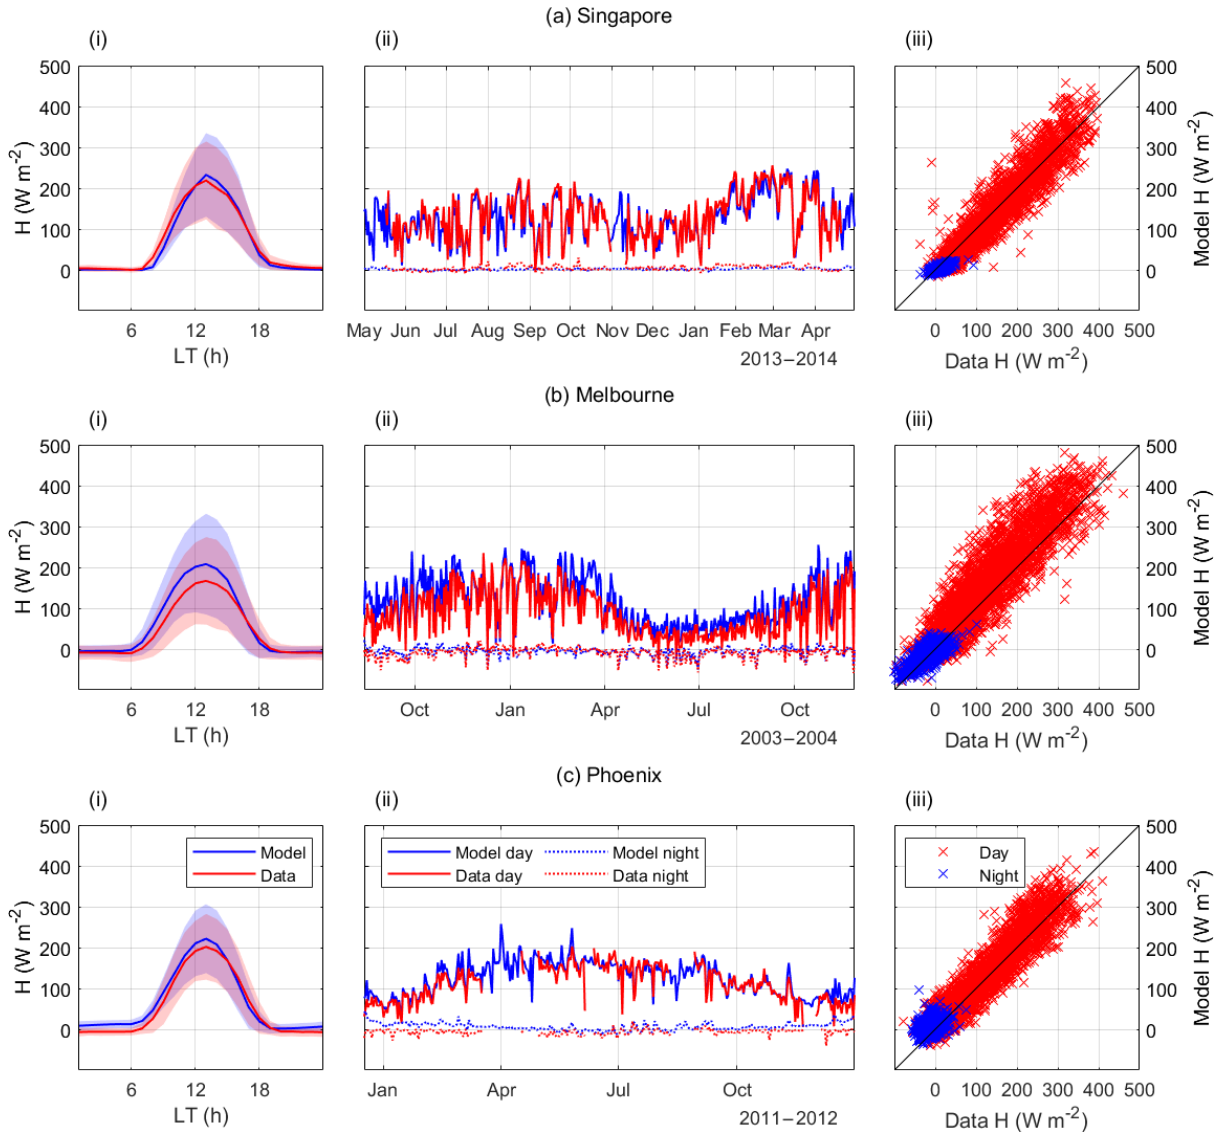
Figure 5. Comparison of modelled and measured sensible heat flux H for the sites in (a) Singapore, (b) Melbourne, and (c) Phoenix. (i) Average diurnal cycle (lines) ± 1 standard deviation (shaded area). (ii) Time series of mean daytime (solid lines) and nighttime (dashed lines) fluxes. (iii) Scatter plot of measurements and simulations of hourly daytime and nighttime